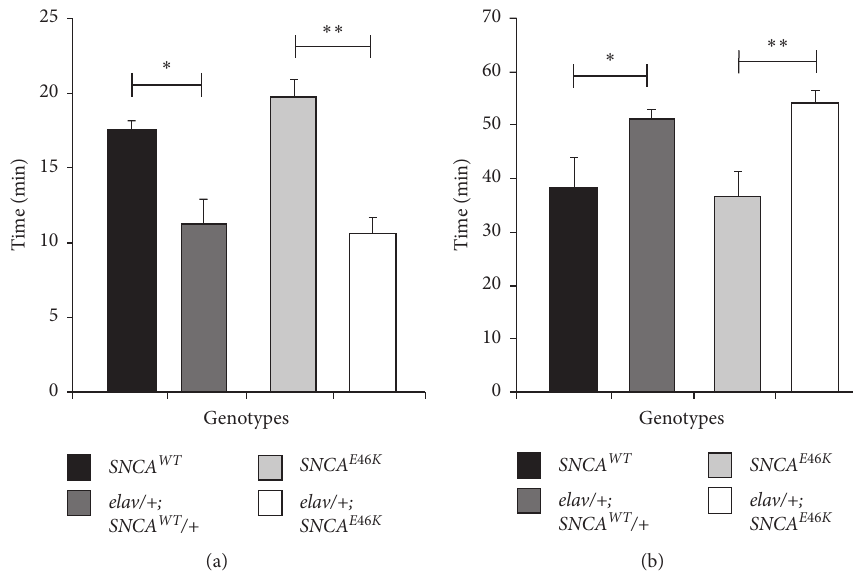
Figure 8: SNCA E46K PD model flies are more sensitive to ethanol vapour. Ethanol exposure sensitivity 50% (ST50) (a) and recovery 50% (RC50) (b) values of SNCA E46K expressing transgenic flies were compared to the control genotype. The ST50 was 19.7 ± 2min and 10 ± 1min in the control genotype ( UAS-SNCA E46K /+ ) and elav; SNCA E46K /+ flies, respectively. The values show a significant decrease in the sensitivity of SNCA E46K PD model flies ( p < 0 . 01; by one-way ANOVA; n � 32). The recovery to 50% of the population was found to be 39 ± 4min for control insects while the time for recovery for the elav ; SNCA E46K /+ flies was 54 ± 2 min. These data indicate lower ethanol resistance in α -synuclein transgenic flies ( ∗ p < 0 . 05 , ∗∗ p < 0 . 01 , by ANOVA; n � 32).